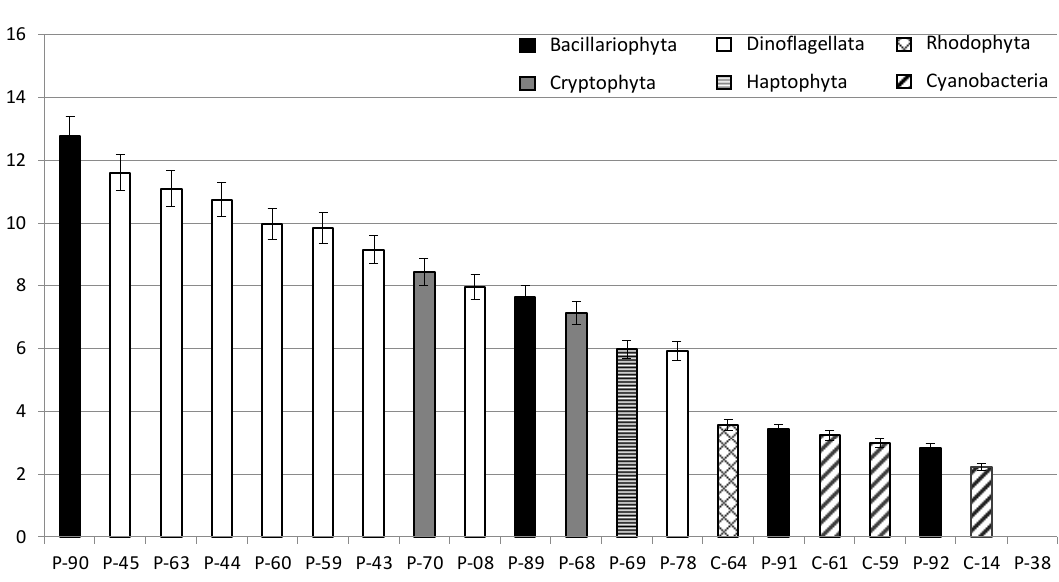
Figure 3. Extraction yield in methanol, in percent of dry matter, of tropical microalgae.